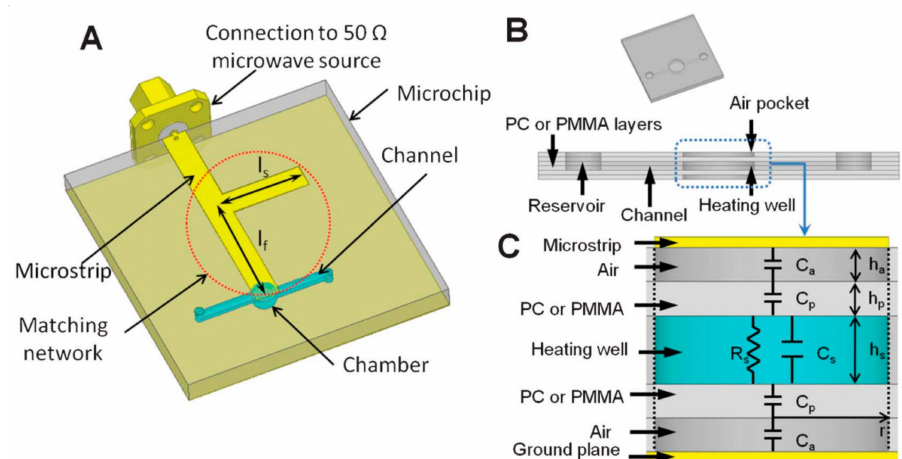
Figure 4. The model of Polymerase Chain Reaction (PCR) microreactor with microstrip circuit ( A ), overall and cross- section of PCR chip ( B ) and the replacement scheme of the system with the heating well as a load ( C ) [61]. Reprinted from Marchiarullo, D.J.; Sklavounos, A.H.; Oh, K.; Poe, B.L.; Barker, N.S.; Landers, J.P. Low-power microwave-mediated heating for microchip-based PCR. Lab Chip 2013 , 13 , 3417–3425, doi:10.1039/c3lc50461a with permission from Royal Society of Chemistry.